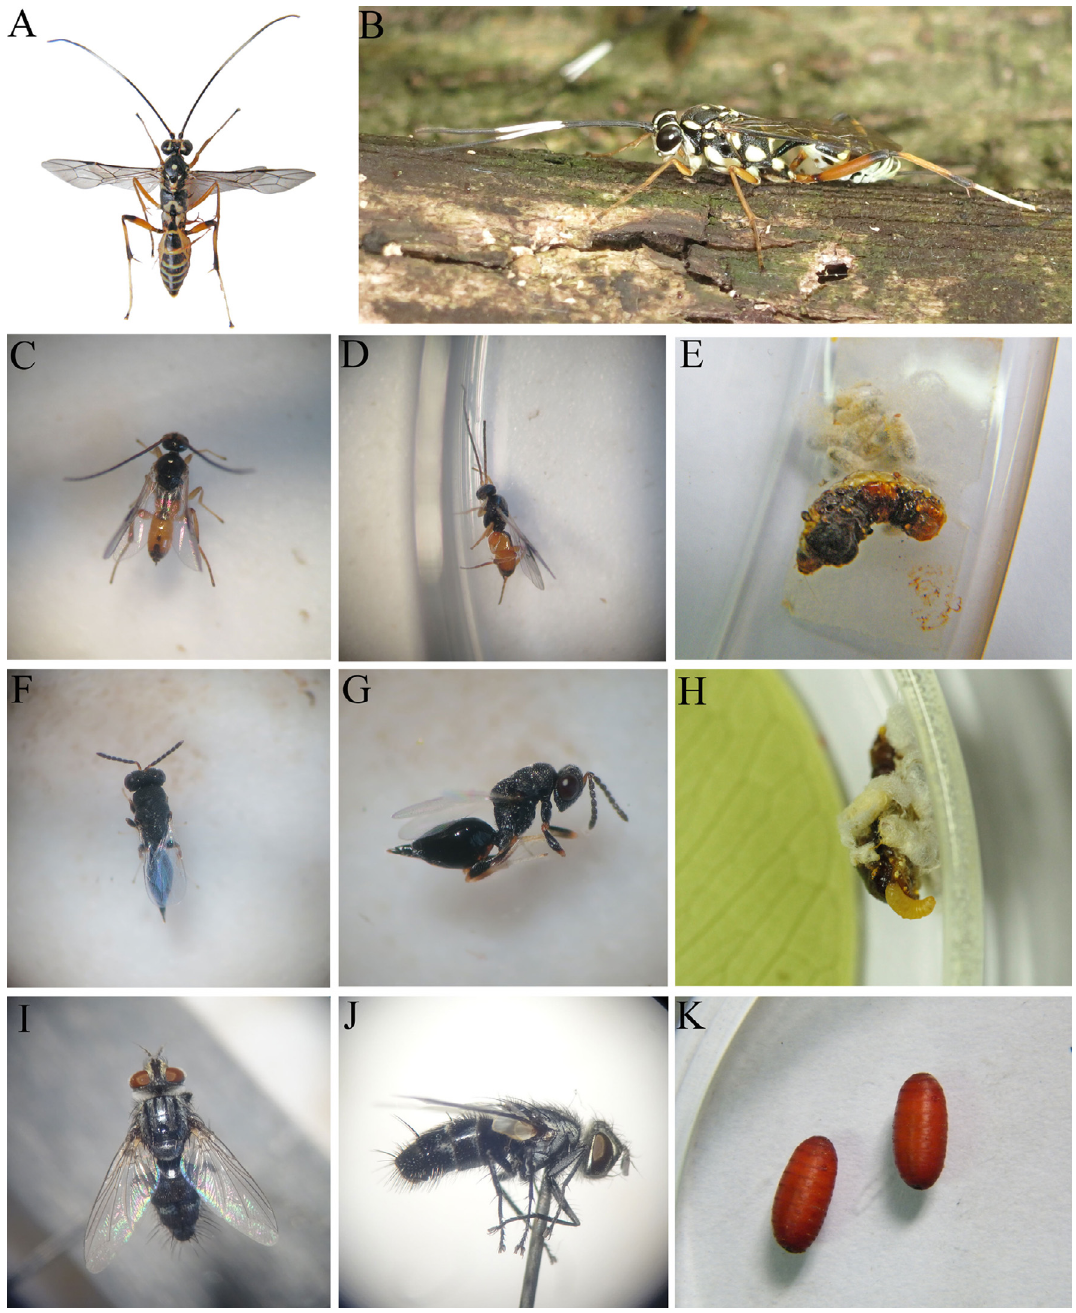
Figure 2. Endoparasitoids of Phauda flammans larvae. A–B: Dorsal and profile view of adults in Gotra octocinctus . C–E: Dorsal and profile view of adults and cocoon in Apanteles sp. F–H: Dorsal and profile view of adults and cocoon in Eurytoma verticillata . I–K: Dorsal and profile view of adults and cocoon in Exorista yunnanica . Table 1. Parasitism by parasitoids on Phauda flammans . Order Family Species P.A/C.I Parasitism (%) Species Order Total Hymenoptera Ichneumonidae Gotra octocinctus 75/1032 Braconidae Apanteles sp. 43/1032 4.2 Eurytomidae Diptera